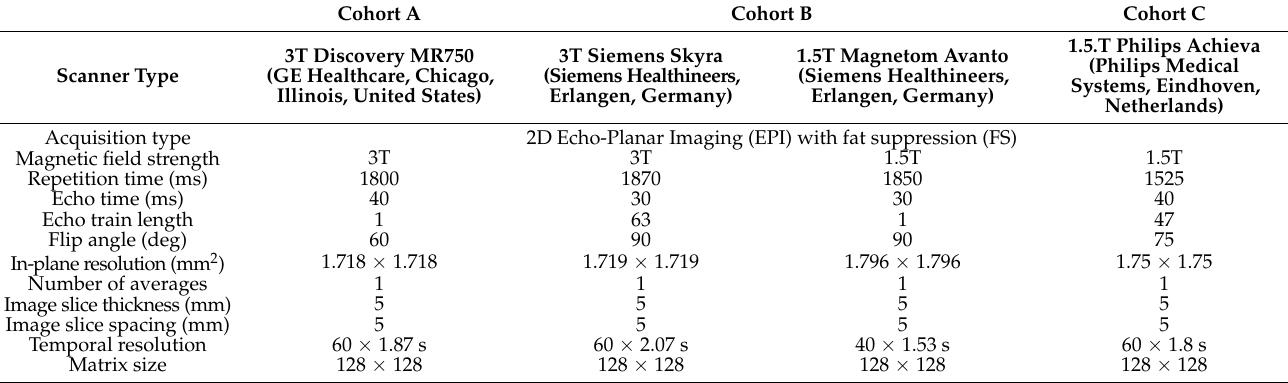
Table 1. Imaging protocol parameters for the patient